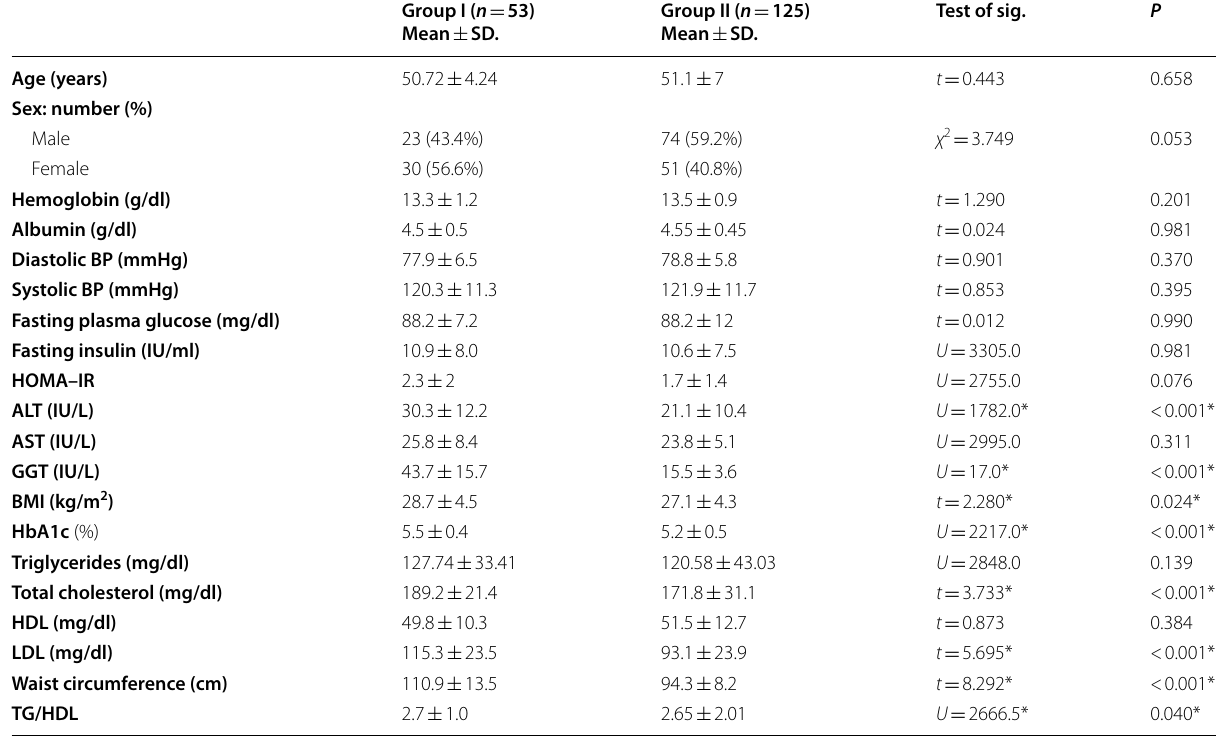
Table 1 Comparison between the two studied groups according to different parameters